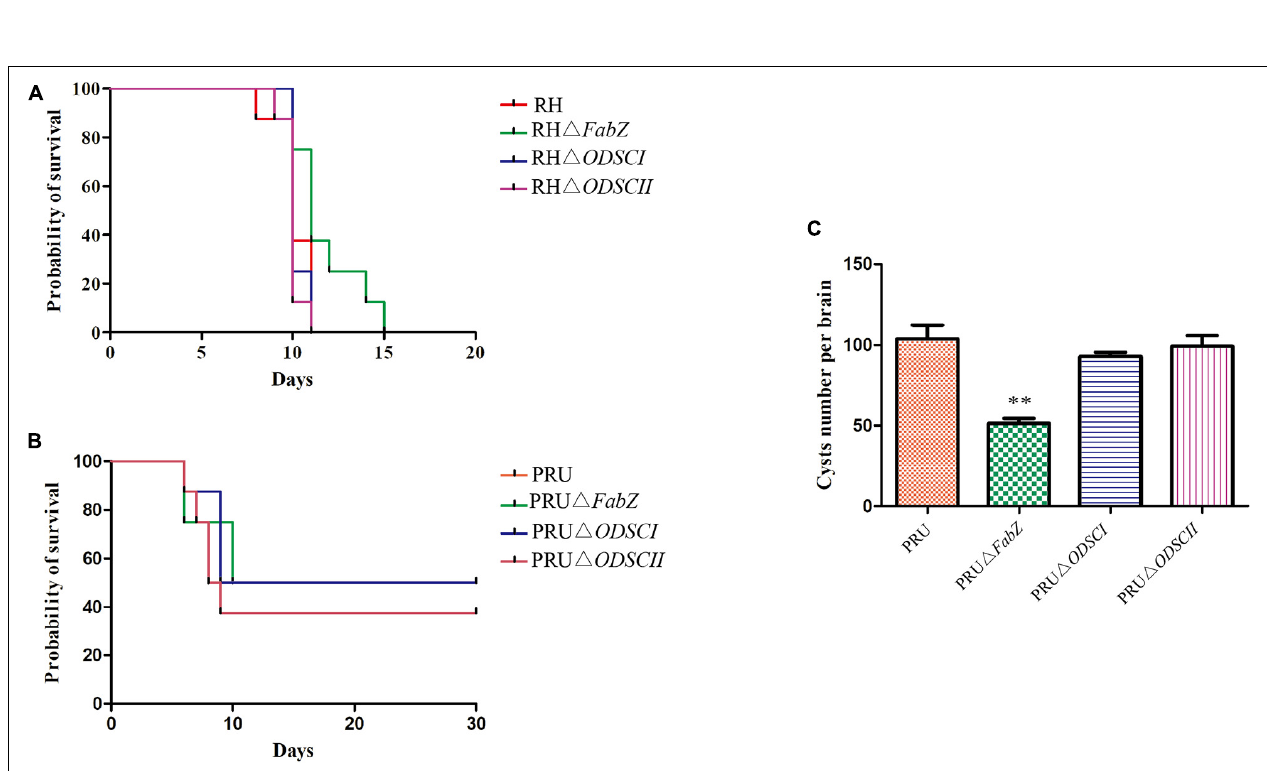
FIGURE 6 | The virulence and cyst forming ability of (cid:49) FabZ , (cid:49) ODSCI, or (cid:49) ODSCII in vivo . (A) The survival of Kunming mice inoculated by 100 tachyzoites of the RH (mutant or wild-type) strains. (B) The survival of Kunming mice infected by 5 × 10 4 tachyzoites of the PRU (mutant and wild-type) strains. Mice infected by RH (A) or PRU (B) strain were checked twice daily by two independent observers for clinical signs and a Kaplan Meier survival curve plotted the infected mice that reached their humane endpoints. (C) The number of cysts in the mouse brain homogenates were counted at 30 days after mice were infected by 5 × 10 4 PRU tachyzoites. The data are shown as means ± SEMs (8 mice/group). ∗∗ P < 0.01; ns, non-significant by Student’s t -test.